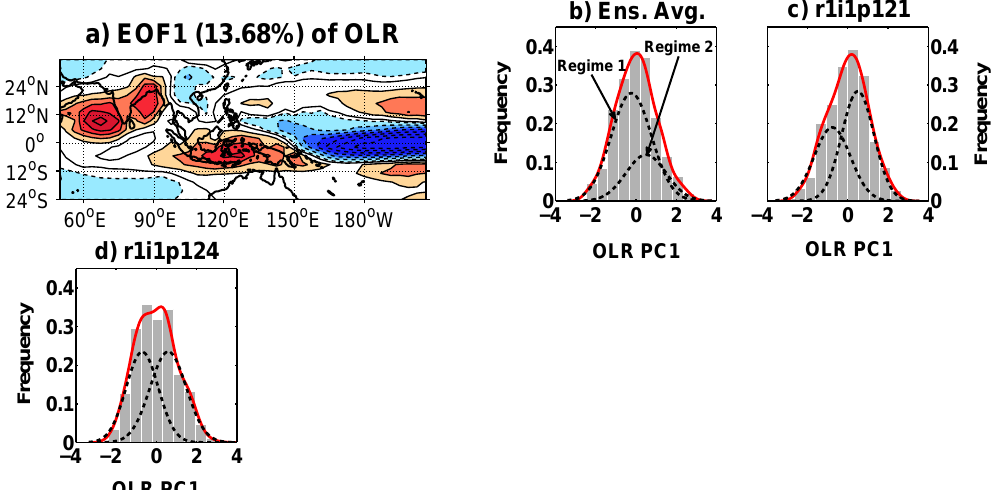
Figure 7. Regime behaviour in GISS-E2-R model simulations. (a) Dominant OLR pattern (EOF1). Positive (negative) contours are shown by solid (dotted) lines. (b) PDF estimate of PC1 of OLR (red solid line) and each regime (dashed lines) for ensemble average and (c–d) for each of the experiments separately.